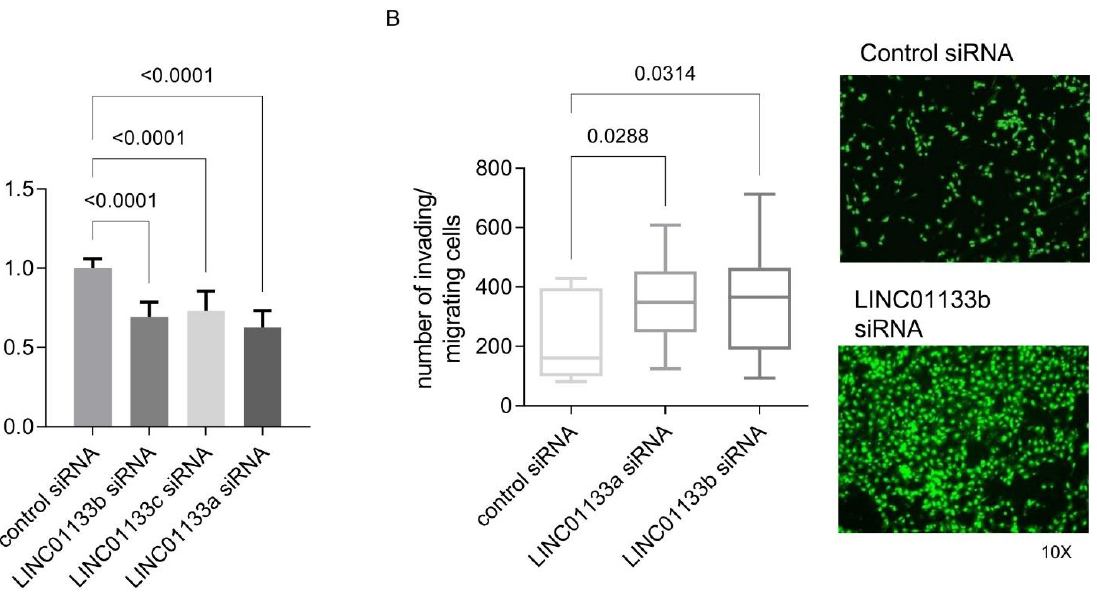
Figure 3. LINC01133 knockdown reduces proliferation and increases invasion of 12Z endometriosis epithelial